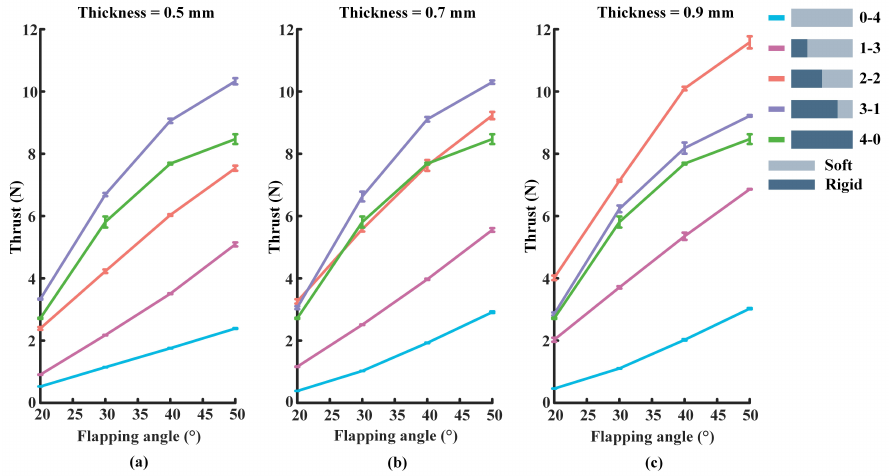
Figure 7. The thrust produced by the foil at the flapping frequency of 1.5 Hz: ( a ) The thickness of the flexible plate of the foil is set to 0.5 mm. ( b ) The thickness of the flexible plate is set to 0.7 mm. ( c ) The flexible plate’s thickness is 0.9 mm.